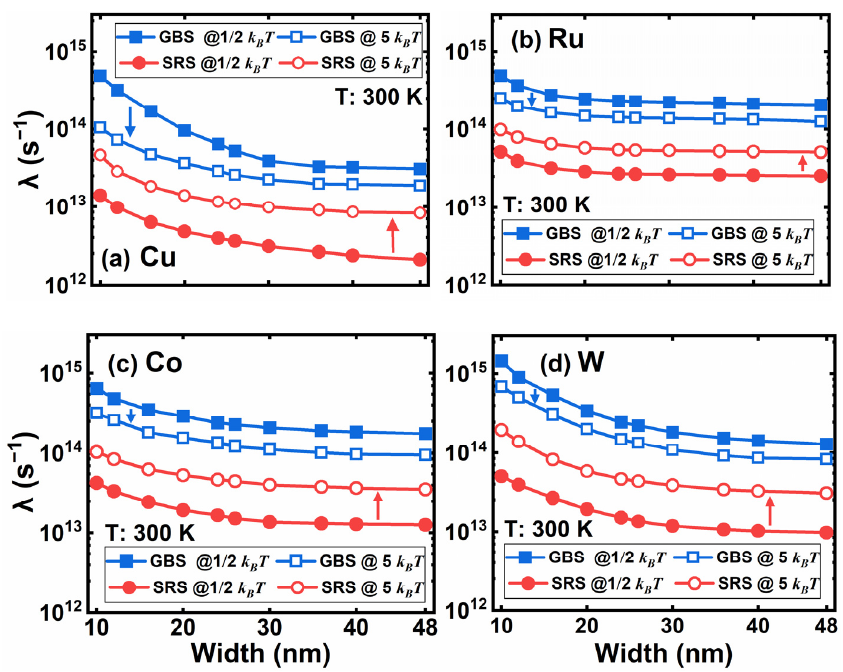
Figure 6. The scattering rate of GB and SR in ( a ) Cu, ( b ) Ru, ( c ) Co, and ( d ) W lines at electron energy levels of k B T /2 and 5 k B T . The linewidth varies from 48 down to 10 nm. It is worth noting that the GBS rate decreases with energy, and the SRS rate increases. The SRS rate is still one order of magnitude lower than the GBS rate at 5 k B T , where the are prone to be less affected by the potential energy of grain boundaries; however, the probability of a collision between hot electrons and the surface increases notably.